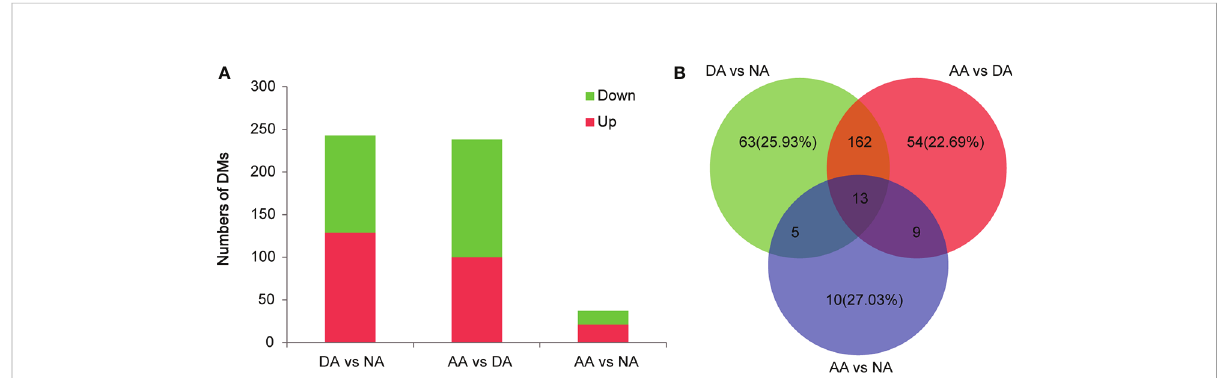
FIGURE 3 Differential metabolites identi fi ed in A . japonicus during estivation cycles. (A) The numbers of differential metabolites in the comparisons of DA vs. NA, AA vs. DA, and AA vs. NA, (B) Venn diagram of differential metabolites pairwise comparison.